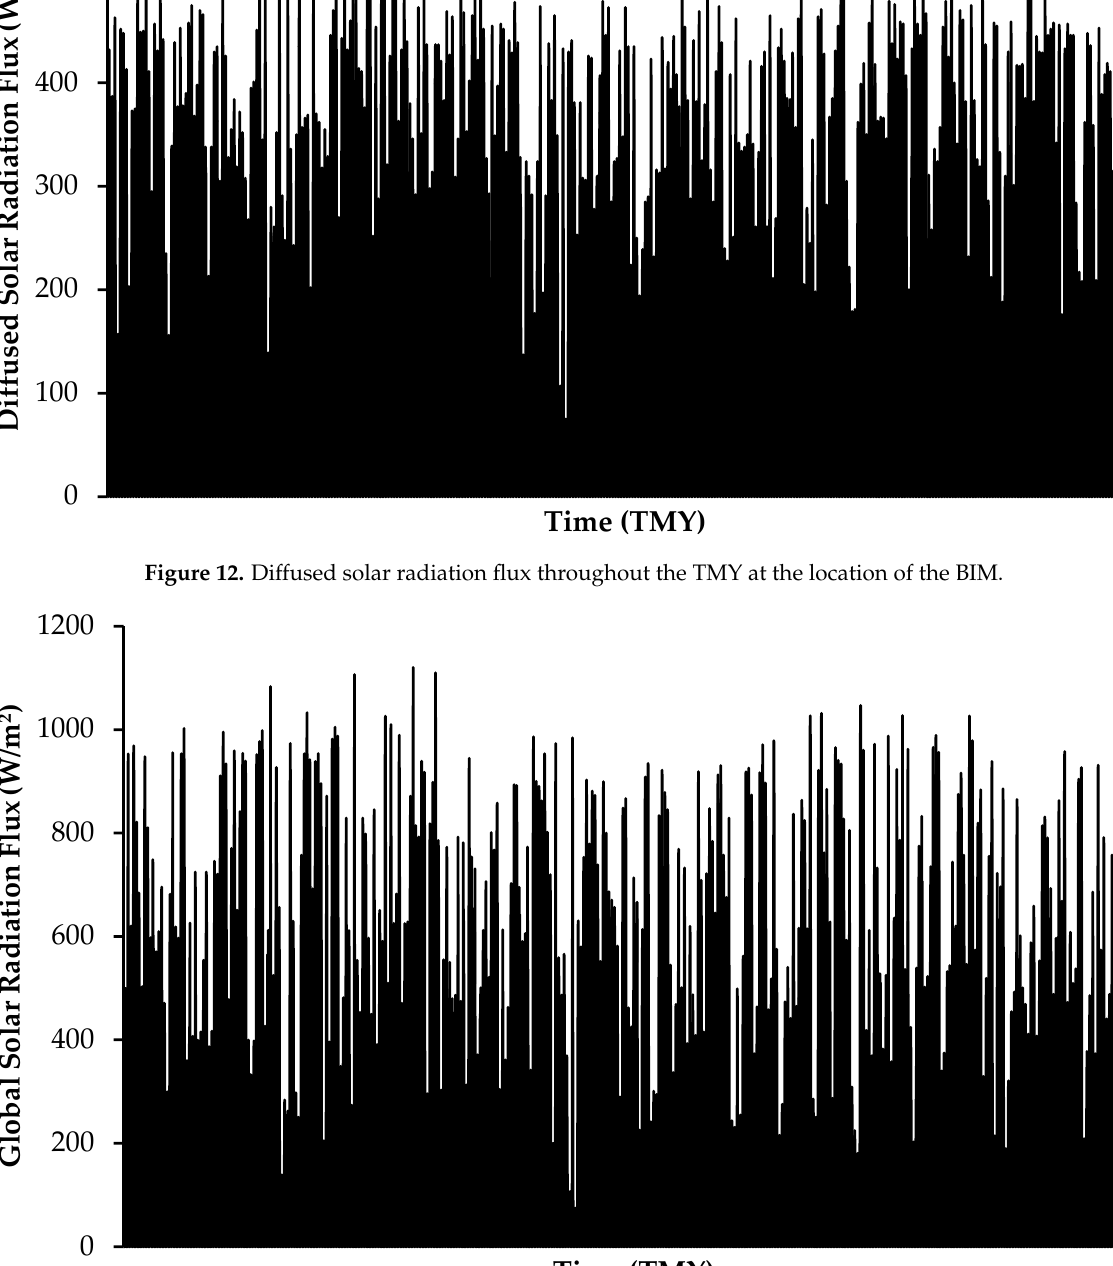
Figure 13. Global solar radiation flux throughout the TMY at the location of the BIM.